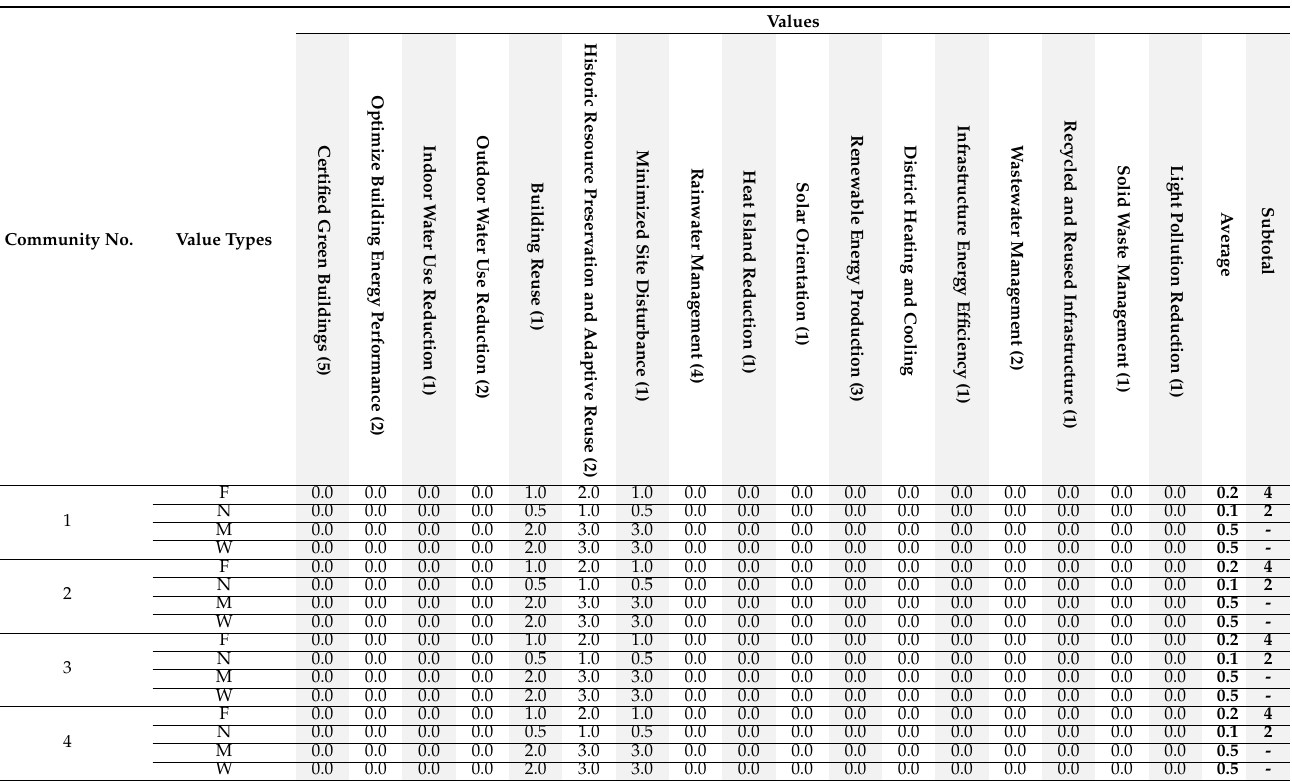
Table 4. Scoring results of green infrastructure &